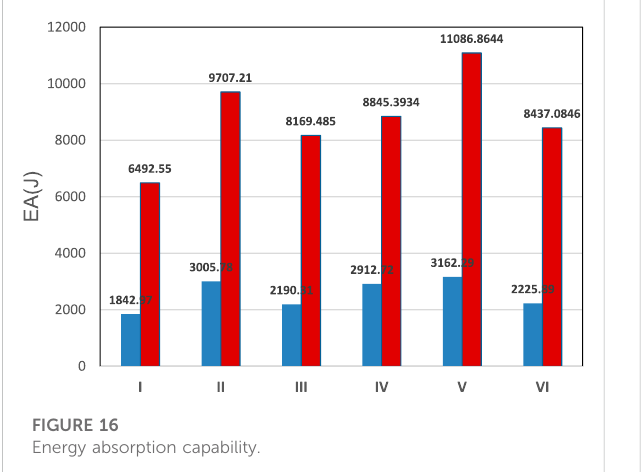
FIGURE 17 Speci fi c energy absorption capability.